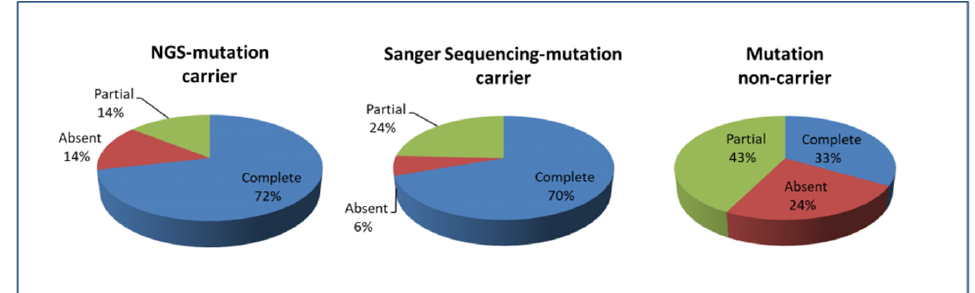
Figure 3. Clinical outcome for 75 patients with unilateral primary aldosteronism who underwent adrenalectomy with respect to detected mutations via customized, targeted next-generation sequencing. Definition of postoperative outcome: evaluation was performed at 12 months postoperatively. Clinical success was defined as resolution of hypertension and no need for anti-hypertensive